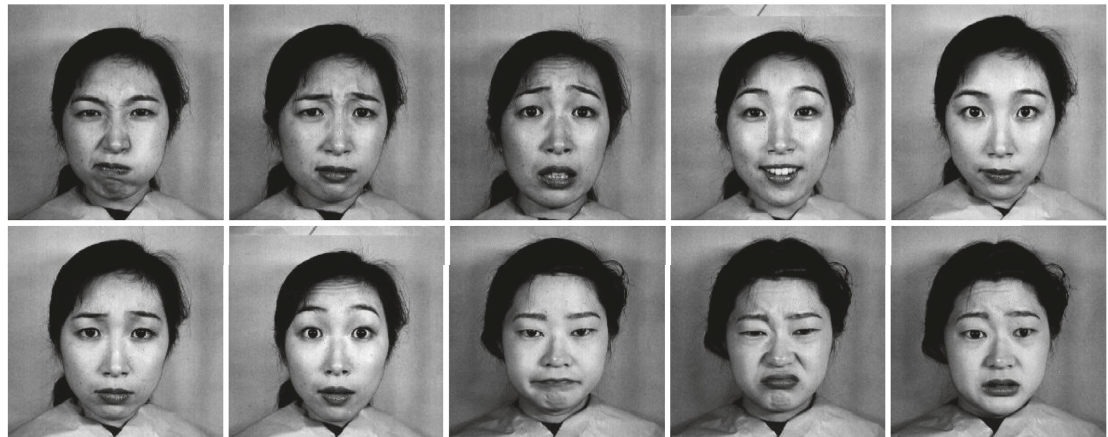
Figure 1: Samples of face images from Jaffe dataset.